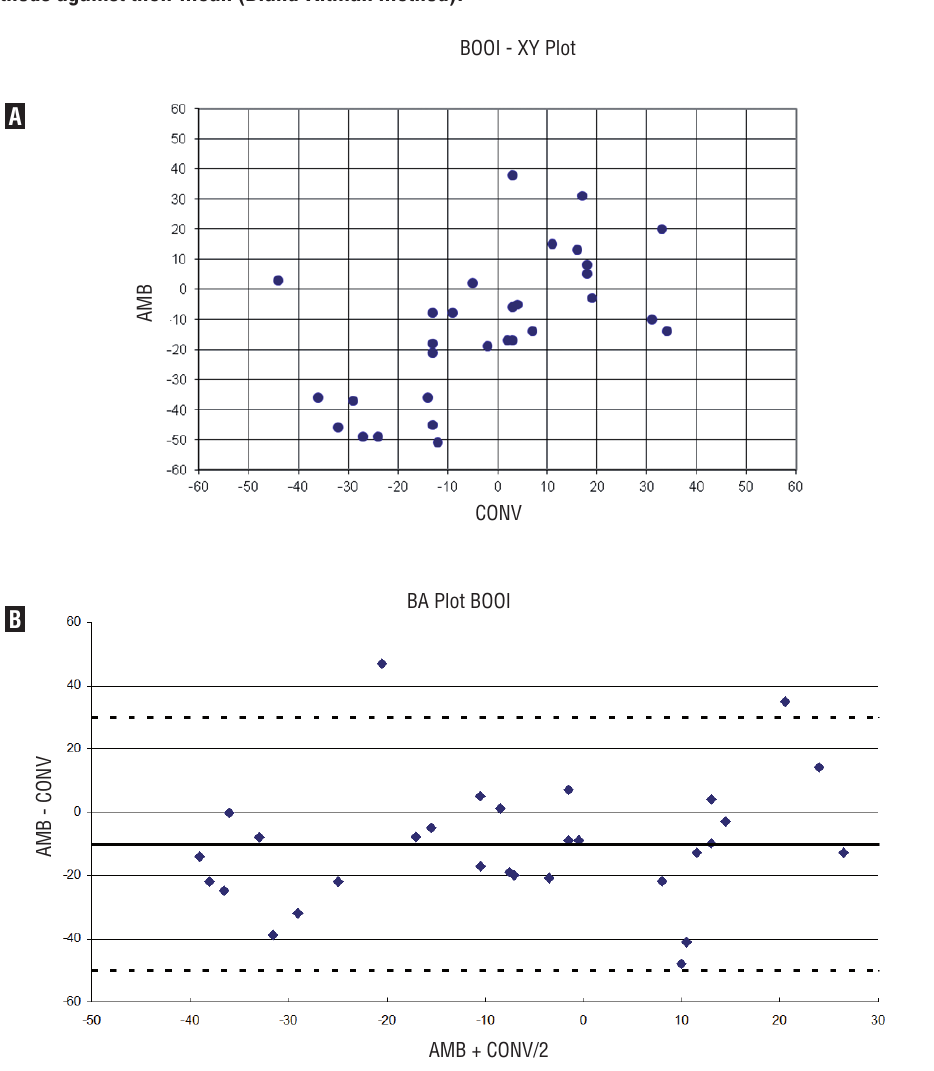
figure 2 - Bladder outlet obstruction index (BOOI): simple plot of the results of conventional cystometry (CONV) against ambulatory urodynamic monitoring (AMB) and plot of the difference between the methods against their mean (Bland-Altman